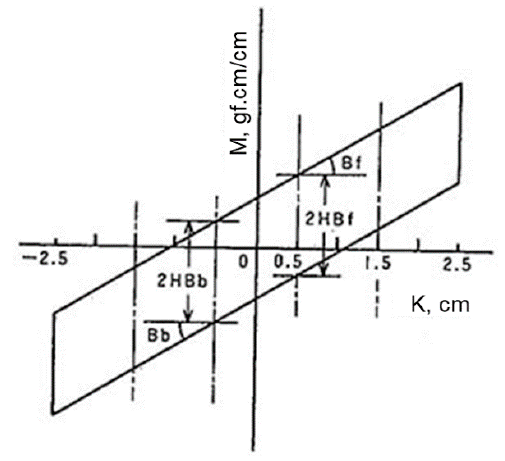
Figure 10. Bending property Figure 10. Bending